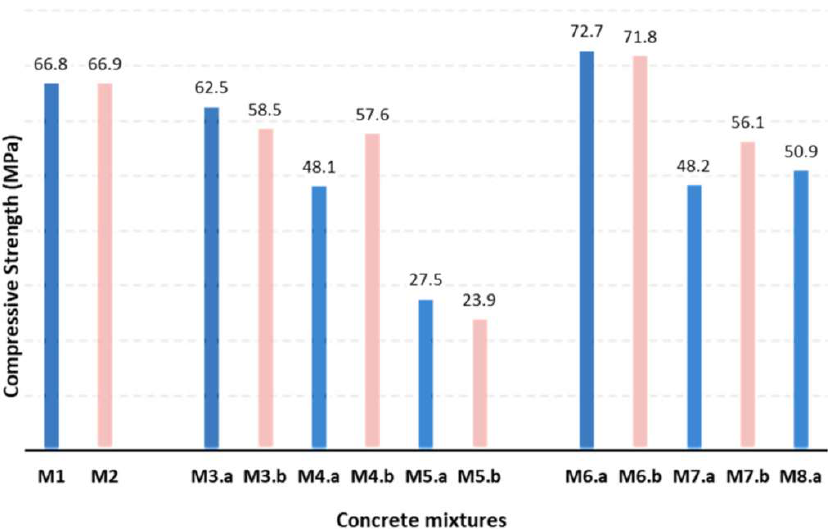
Figure 17. Comparison of the compressive strengths of blast furnace slag seawater concrete at 28 days curing age (M1 is the control group; M2 is the 100% seawater combination; M3 to M5 are fine aggregate rubber replacement groups; M6 to m8 are coarse aggregate rubber replacement groups) [13]. Table 7. Chemical and physical properties of blast furnace slag and rubber (XRF) [9].